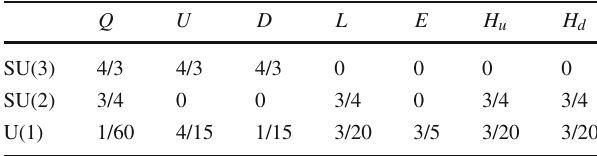
Table 2 Quadratic Casimirs of MSSM fields Table 4 Charge assignments in the U